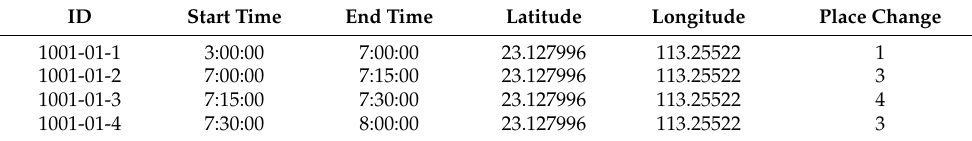
Table 1. Examples of action